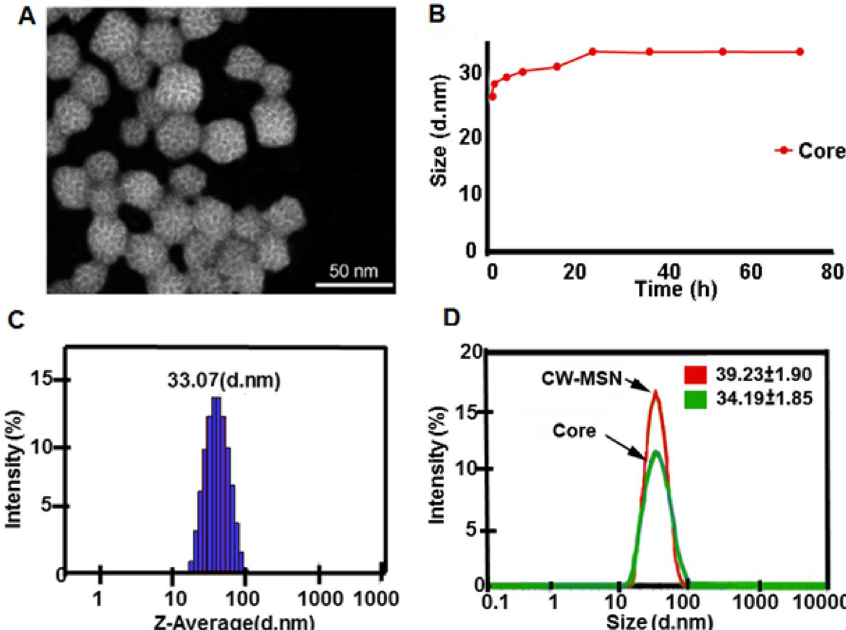
Figure 1. Characterization of the wormhole mesoporous silica nanoparticles (W-MSN). ( A ) Scanning transmission electron micrograph (STEM). Images of CW-MSN Core with an average particle size size of 26 ± 2.3 d.nm. Particles were measured using Image J https ://image j.net/Downl oads. ( B ) Dynamic light scattering (DLS) results indicated that the MSN solution was monodisperse with a recorded PDI of 0.08 At 24